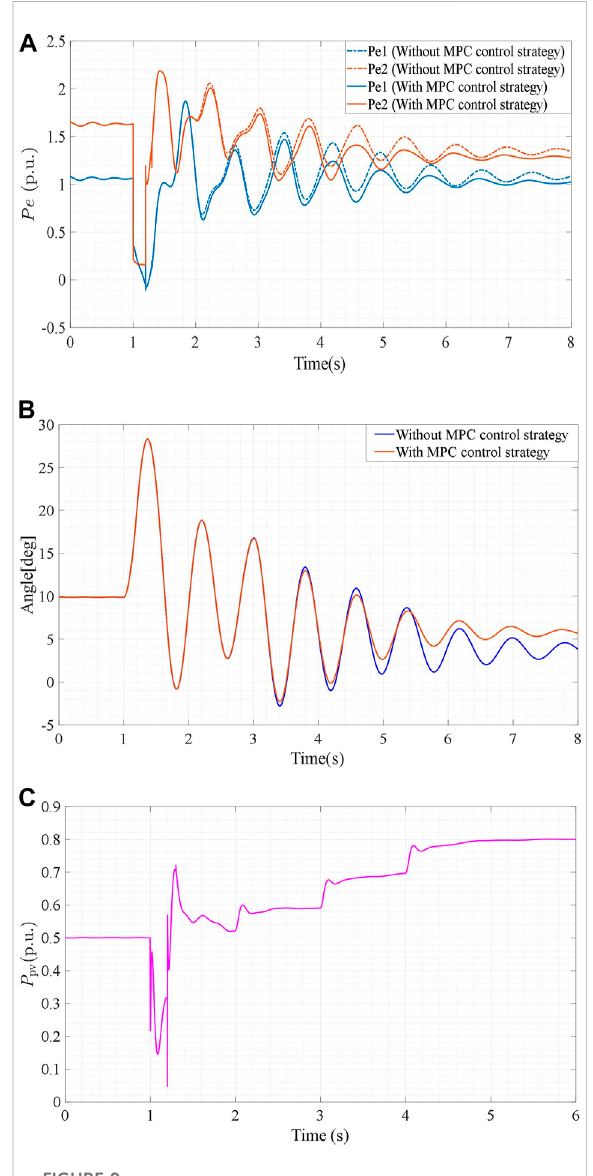
FIGURE 9 (A) : Dynamic performances of the active electromagnetic output powers Pe 1 and Pe 2. (B) : Transient angles of generator 1 δ 1 in the power grid. (C) : Active power output of the PV